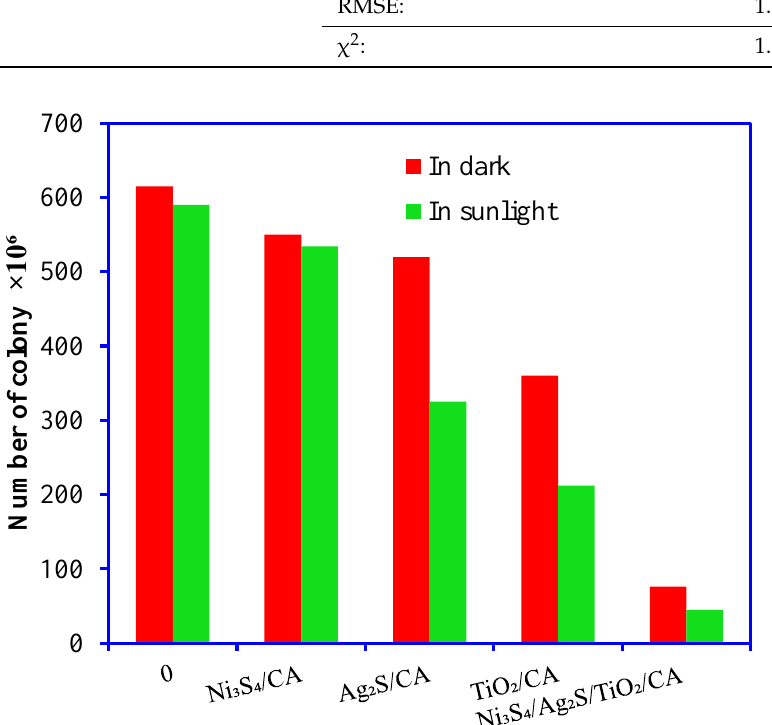
In dark In sunlight